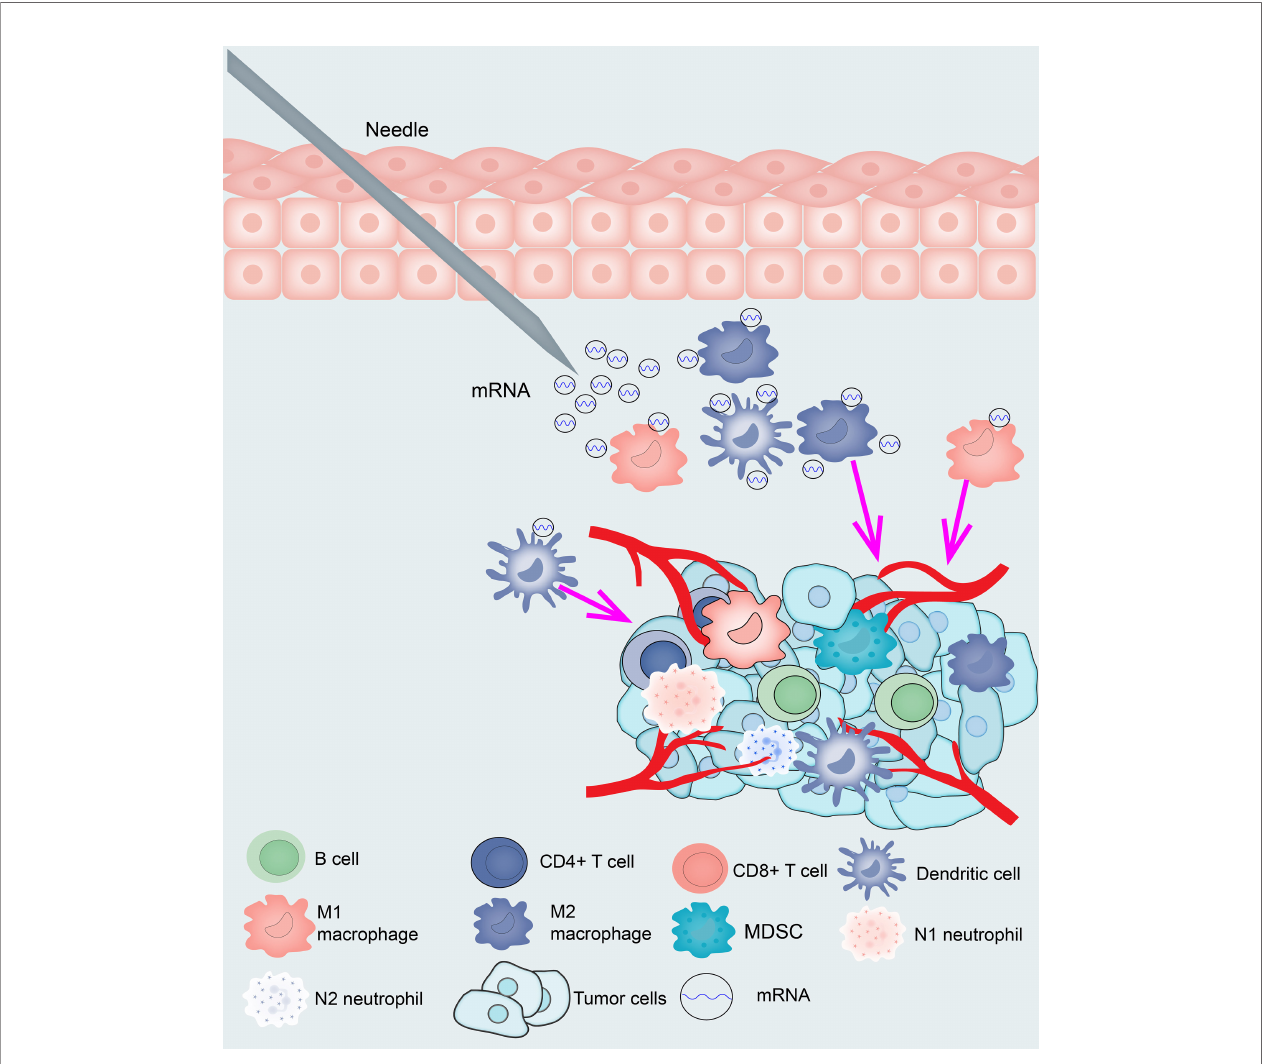
FIGURE 9 | Diagram of mRNA vaccine application pattern in